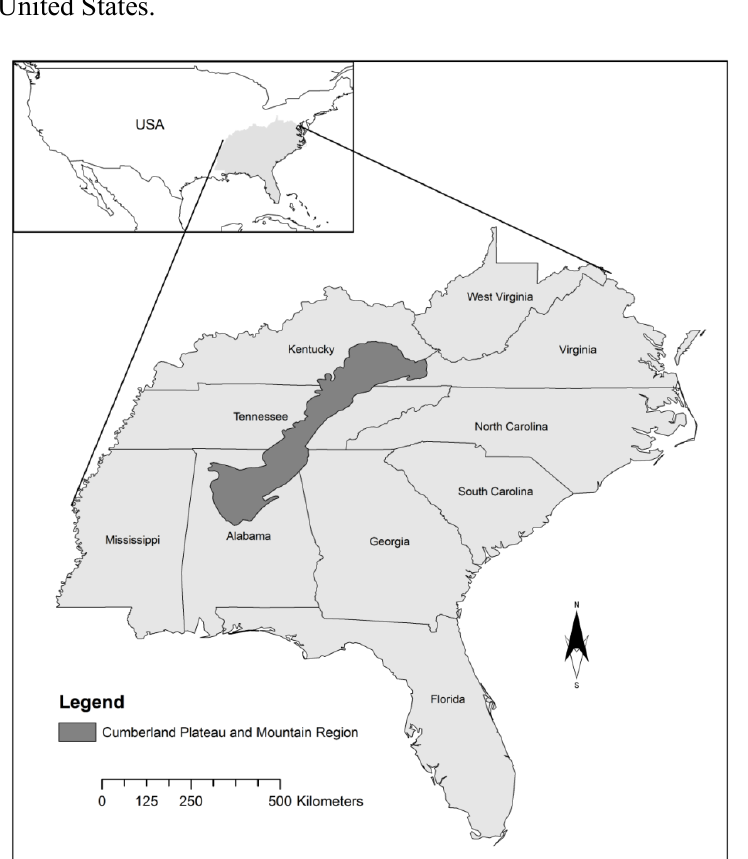
Figure 1. Study area location map: Cumberland Plateau and Mountain region in the southeastern United